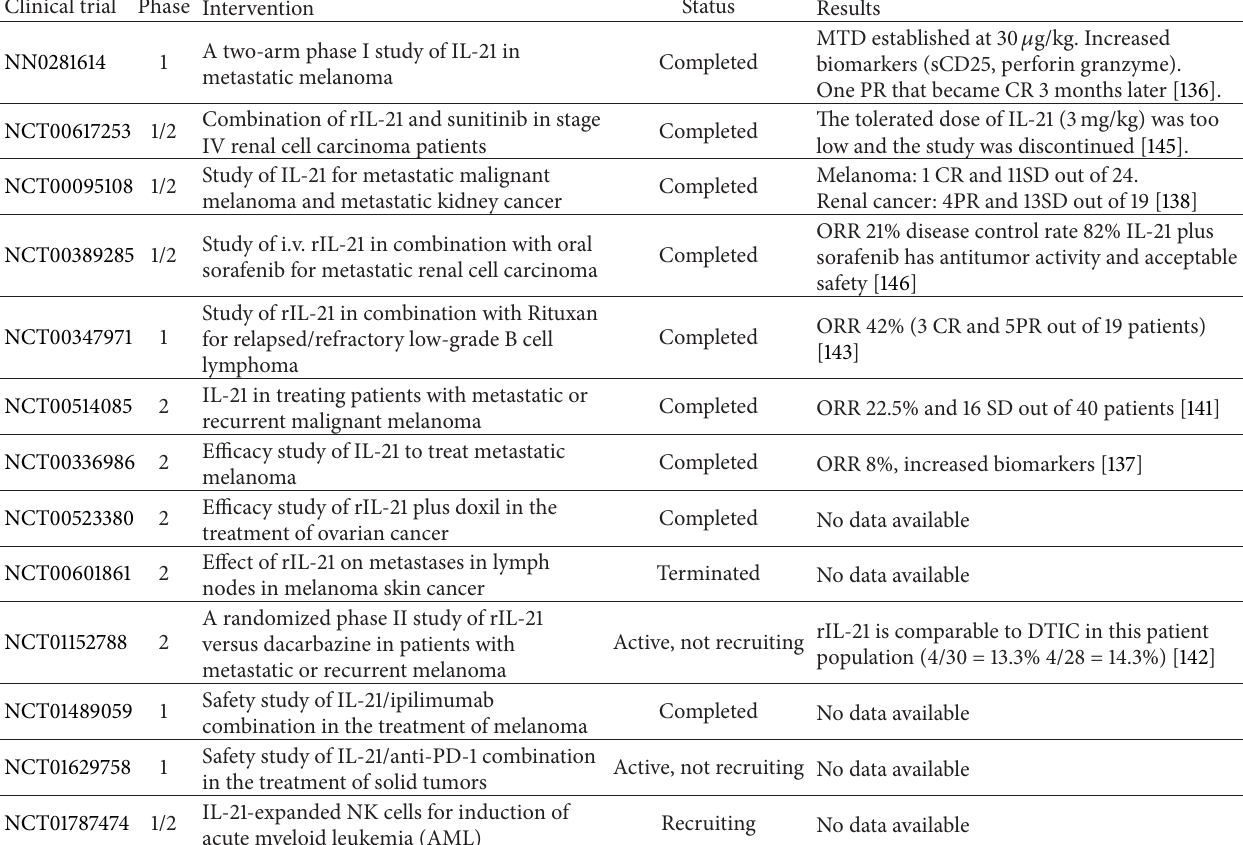
Table 1: Clinical studies of IL-21